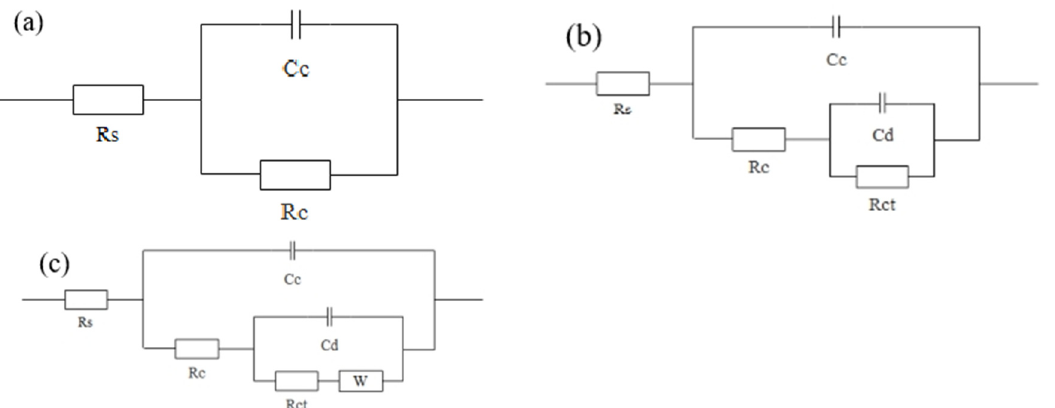
Figure 6. Equivalent circuit diagrams of different immersion stages: ( a ) early stage; ( b ) middle stage; ( c ) late stage.